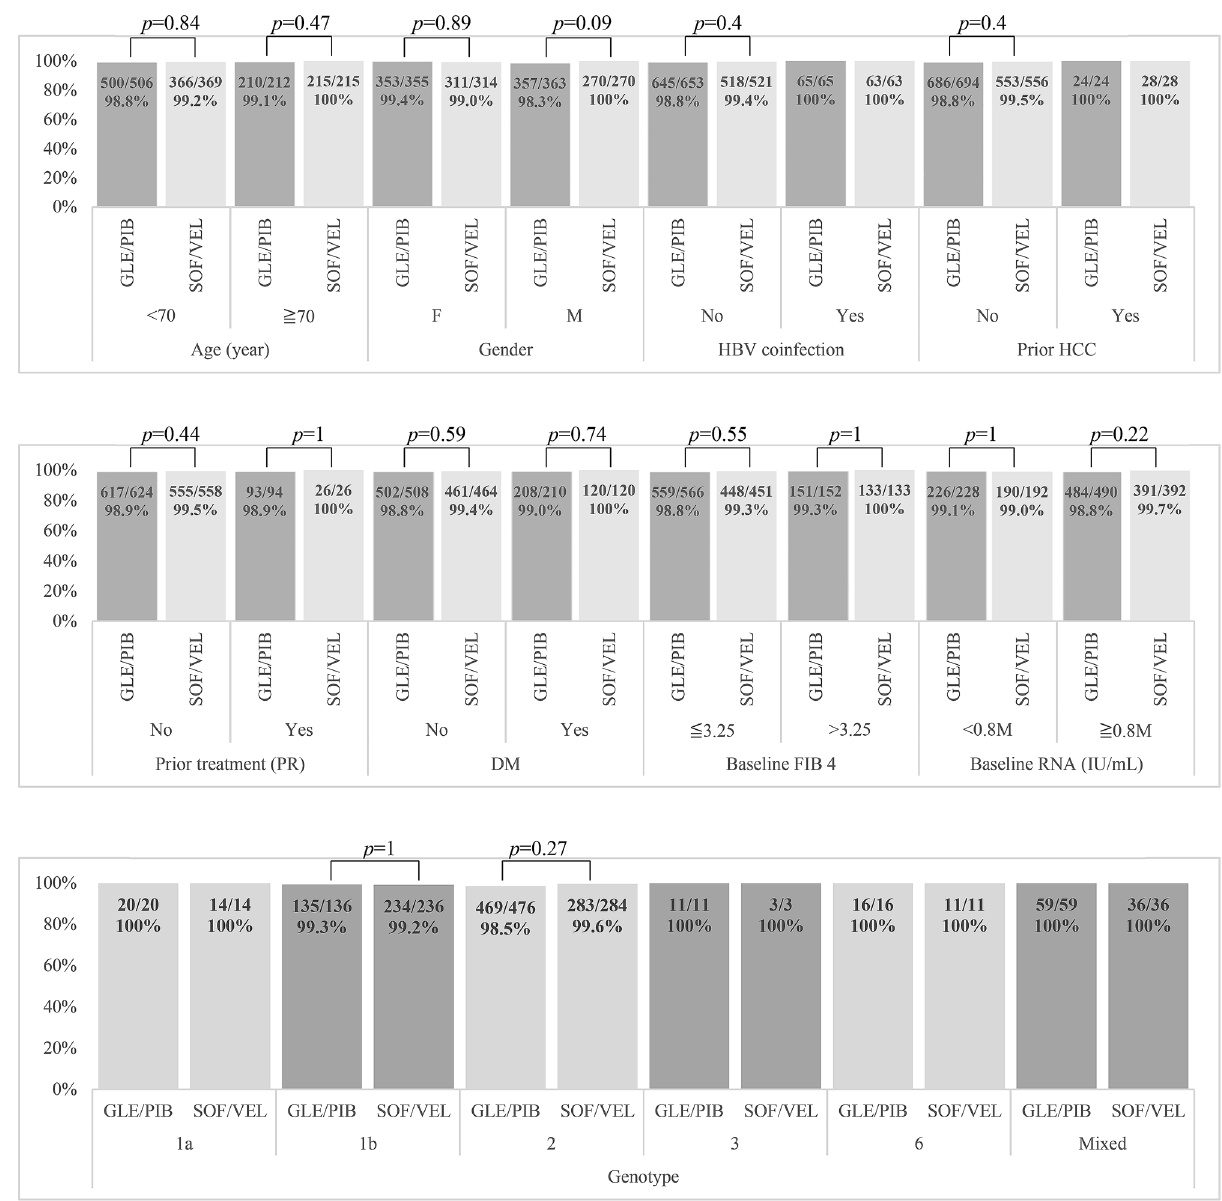
Figure 2. Subgroup analyses of SVR12 (per-protocol set). FIB-4 fibrosis index based on four factors; GLE/ PIB glecaprevir/pibrentasvir; SOF/VEL sofosbuvir/velpatasvir; HBV hepatitis B virus; HCC hepatocellular carcinoma; RNA ribonucleic acid; SVR12 sustained virological response 12 weeks after treatment